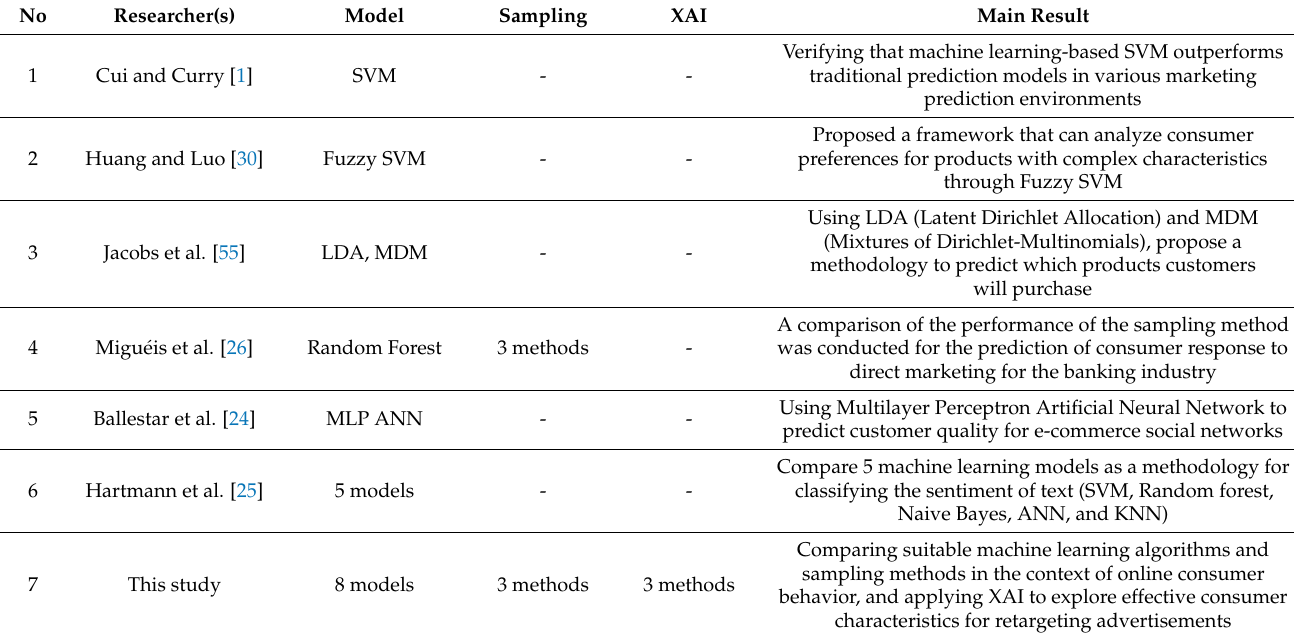
Table 1. Comparison between related research and this